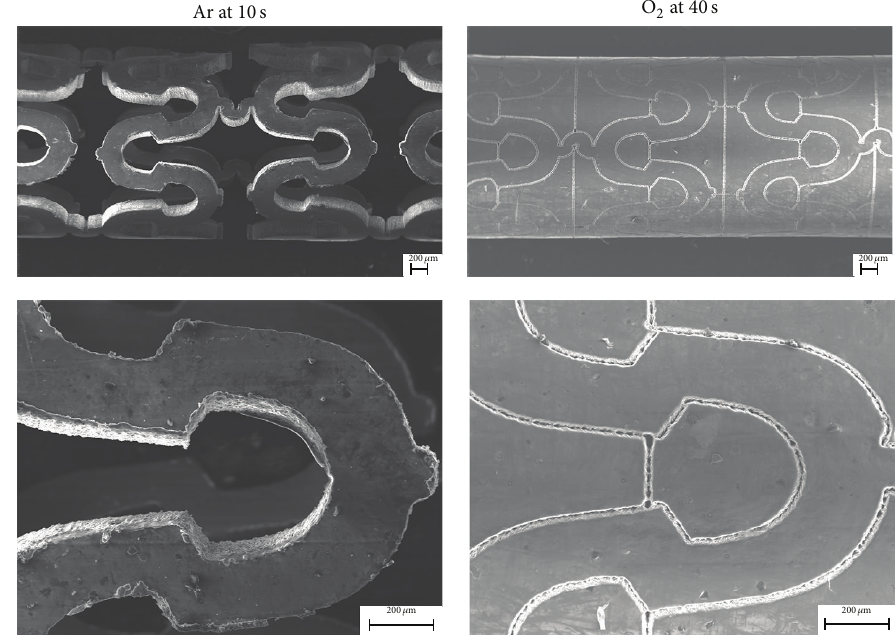
Figure 7: SEM images of the laser microcut stents using Ar and O 2 , after chemical etching.